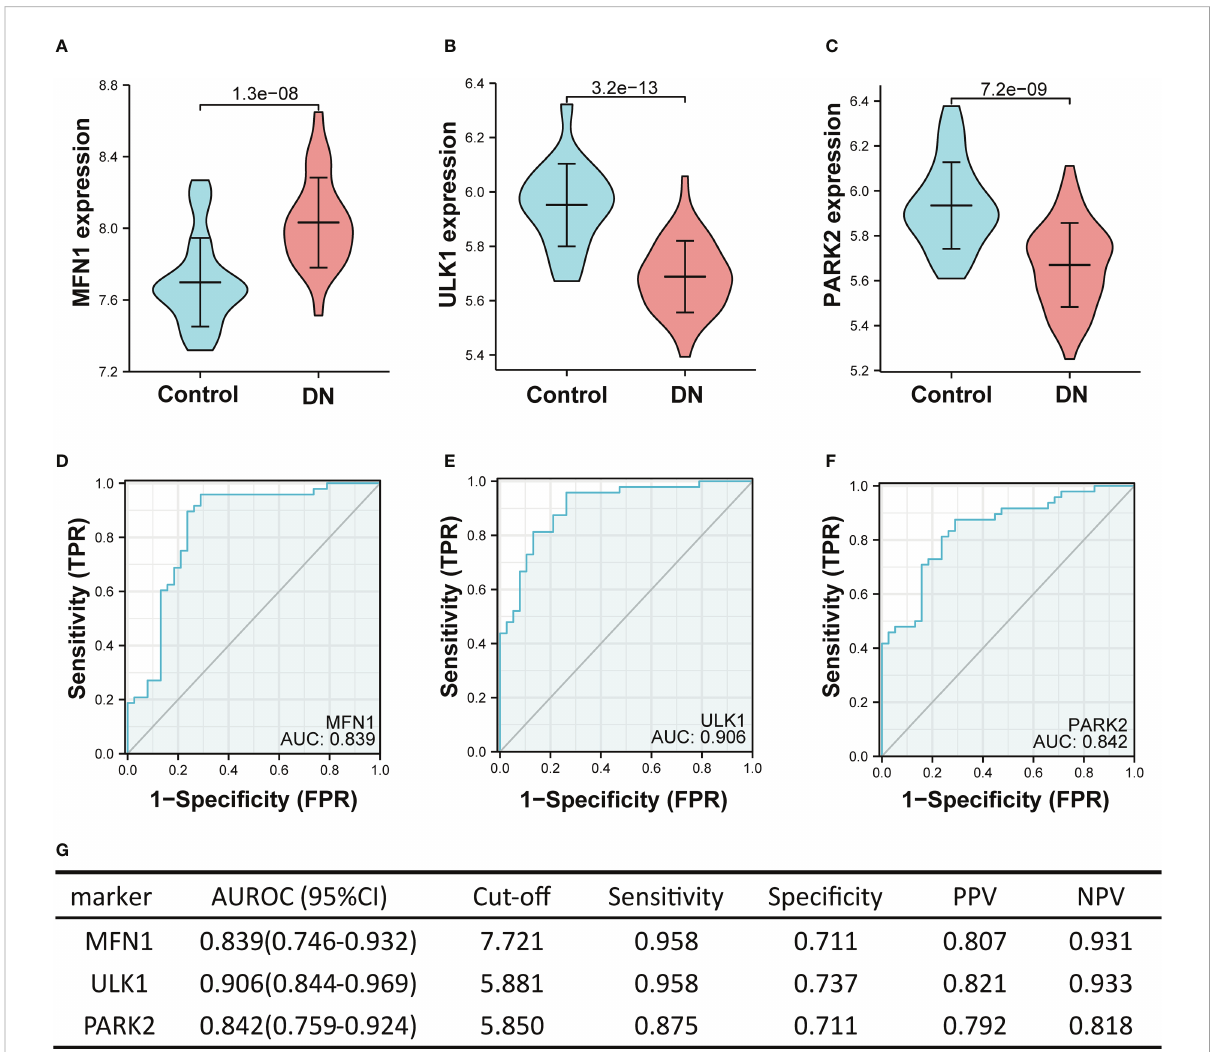
FIGURE 6 The performance of the three hub genes to diagnose DN in the training set. (A – C) Expression difference of the three hub genes in DN and control groups. (D – F) The ROC curve of the three hub genes in DN and control groups. (G) Diagnostic value of the three hub genes for differentiating DN from control groups. PPV, positive predictive value; NPV, negative predictive value; AUROC, area under the receiver operating characteristics curve; CI, con fi dence interval. Data were analyzed by Wilcoxon tests or Student ’ s t